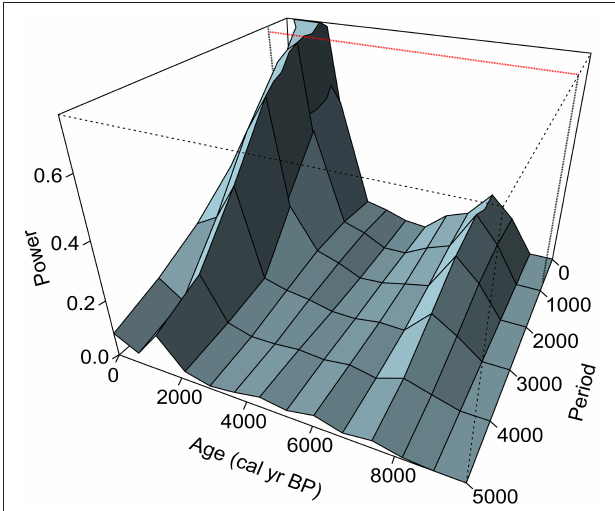
FIGURE 5 | Dynamic Lomb-Scargle periodogram for the SCD time series. Note the increase in power at 700- and 300-year periods during the last 2,000 years. Power values larger than 0.78 are statistically significant ( p = 0.05; depicted with a red line).